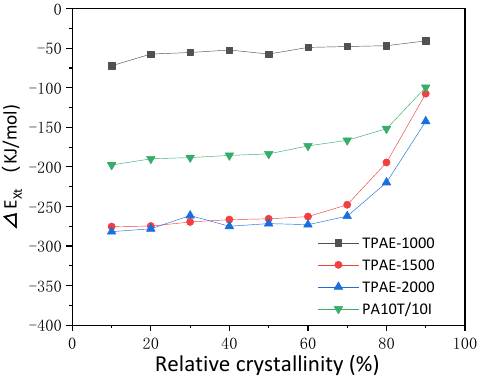
Figure 15. Plot of the effective activation energies of non-isothermal crystallization of TPAEs and PA10T/10I as a function of the relative degree of crystallinity.